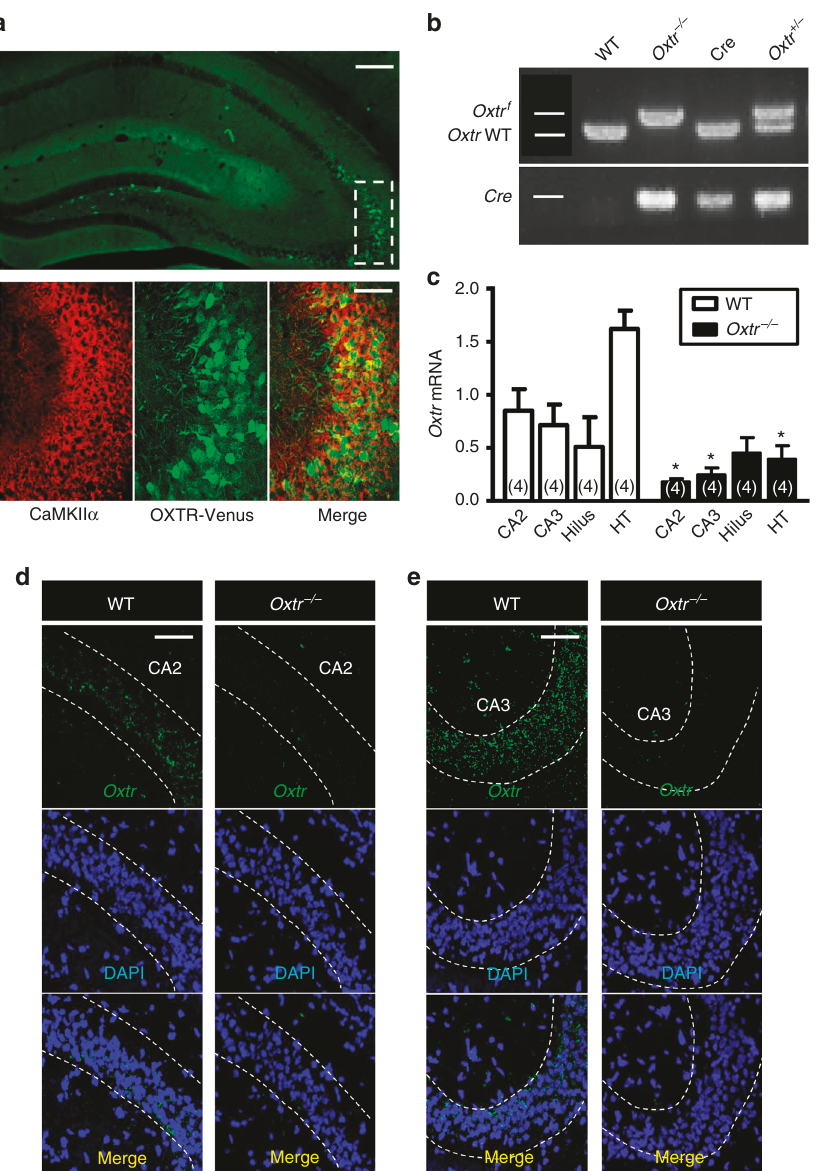
Fig. 2 Conditional deletion of Oxtr in the excitatory neurons of mouse hippocampus. a Top panel , a representative immuno fl uorescence image of OXTR ( green ) expression in the mouse hippocampus. Bottom panels , augmented fi gures showing CaMKII α ( red ) and OXTR ( green ) double-labeling results in rectangle area . Scale bars : top , 200 μ m; bottom , 50 μ m. b PCR screening of tail-derived genomic DNA for selection of Oxtr − / − mice. c Quantitative real-time PCR of Oxtr mRNA in the CA2, CA3, hilus, and hypothalamus ( HT ) regions from WT ( Oxtr f/f ) and Oxtr − / − mice ( n = 4 mice for each group; * P < 0.05, unpaired two-tailed Student ’ s t test). d , e FISH images showing the expression of Oxtr mRNA in the CA2 d and CA3 regions e of WT and Oxtr − / − mice (counterstained with DAPI, blue ). Scale bar , 50 μ m. Data was replicated in four